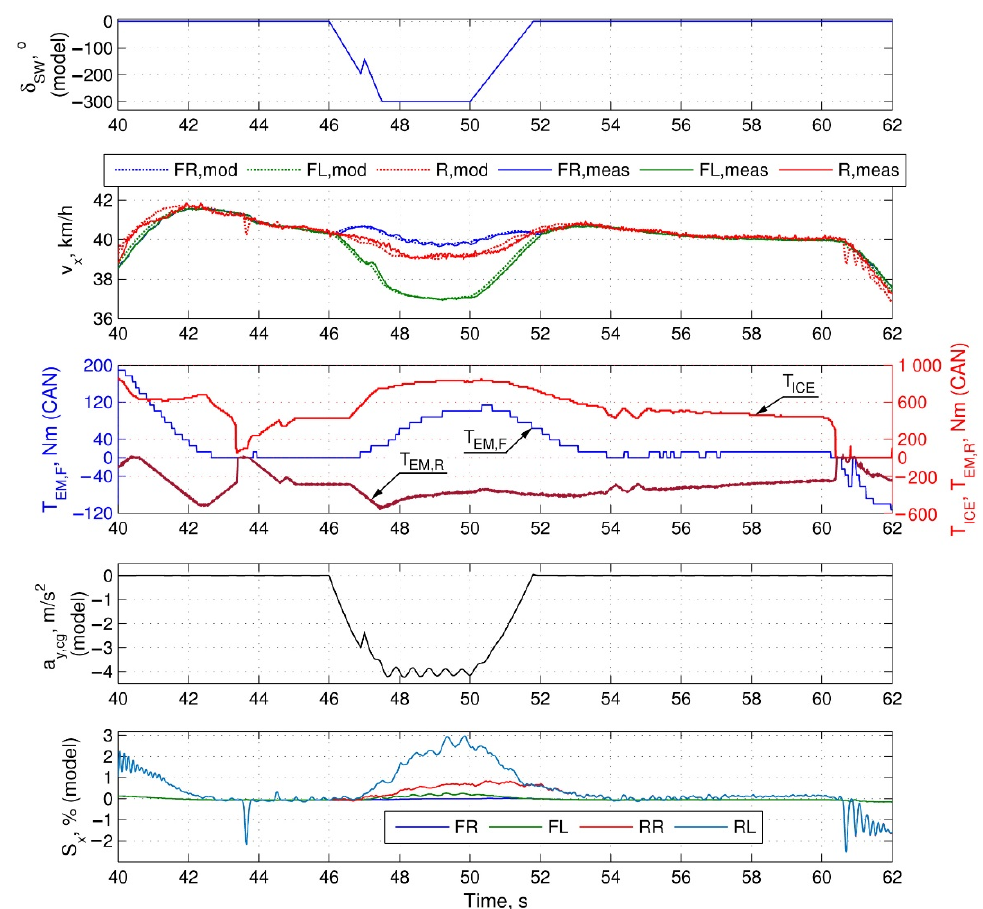
Figure 7. Example of CiL testing results simulating the hybrid powertrain operation when the vehicle negotiates a turn.